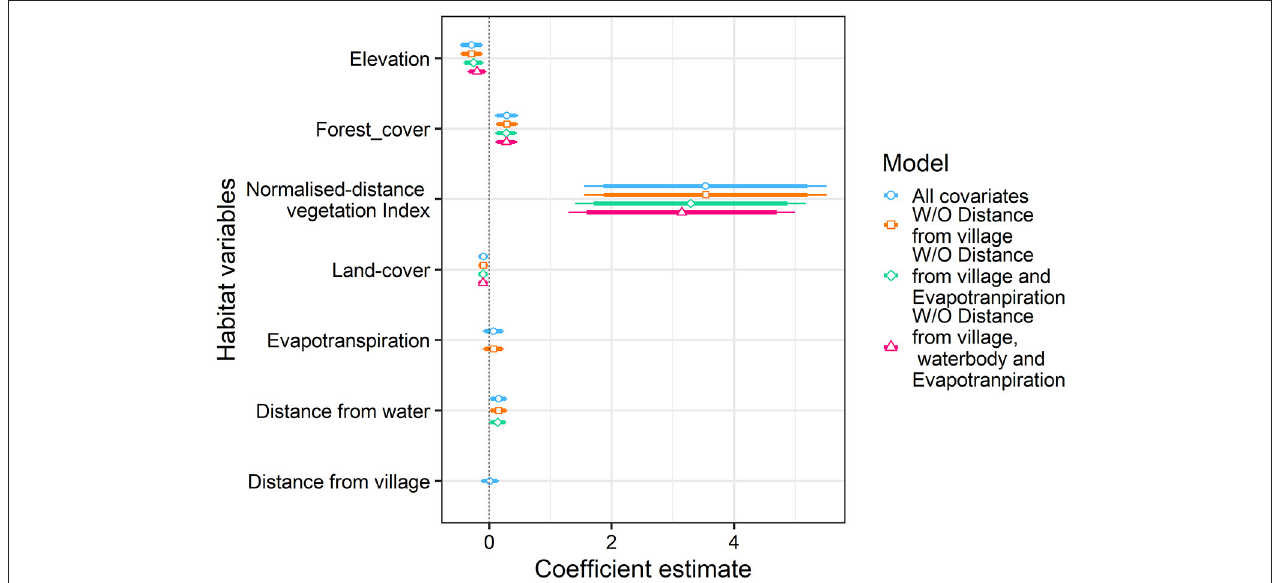
FIGURE 3 | Scaled estimates of environmental covariates used in glm model to evaluate habitat-use are given for honey badger. Broad lines depict the 95% confidence interval of each habitat covariate, while the narrow lines represent 90% confidence interval.